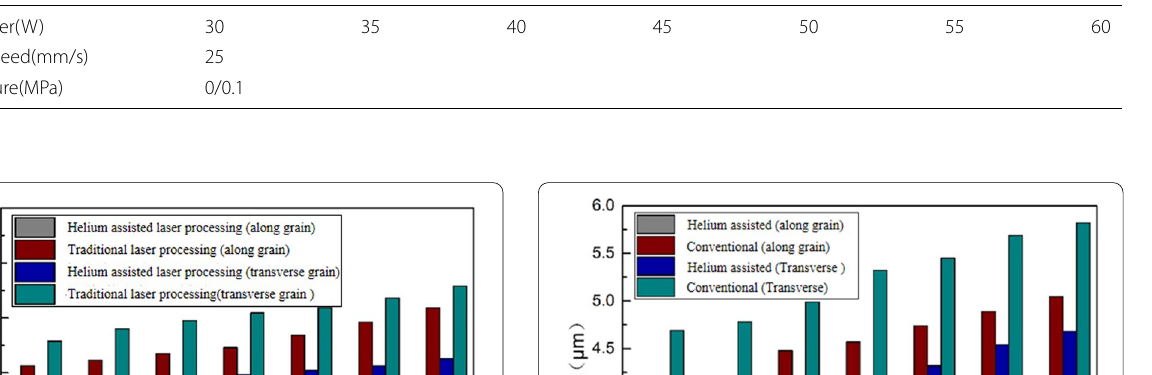
Table 1 Cherry wood processing parameters by inert gas-assisted laser Process parameters